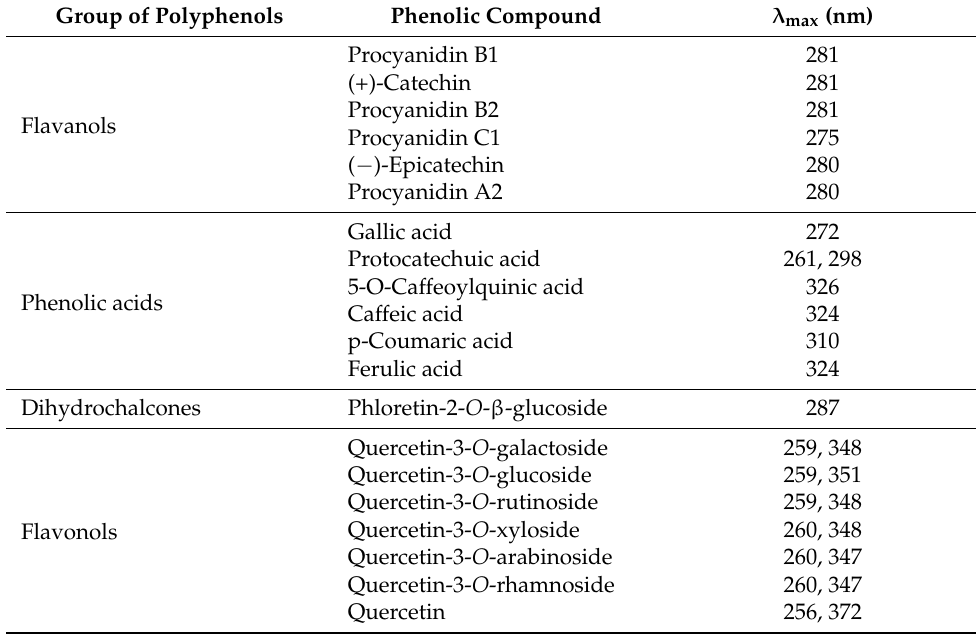
Table 4. Absorption maximum ( λ max ) of polyphenols occurring in apples and belonging to flavanols, phenolics acids, dihydrochalcones and flavonols classes. Reproduced under the terms of the Creative Common CC BY license which permits reuse in any medium, provided the original open access work is properly cited [21]. Phenolic Compound λ max